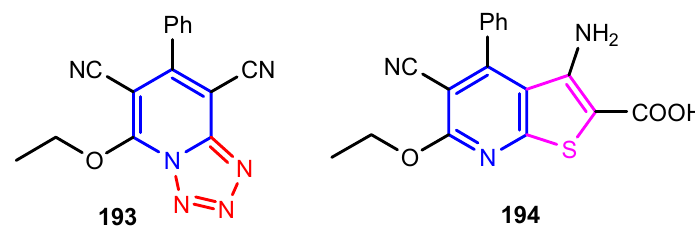
Figure 19. Structures of compounds 193 and 194 [81].